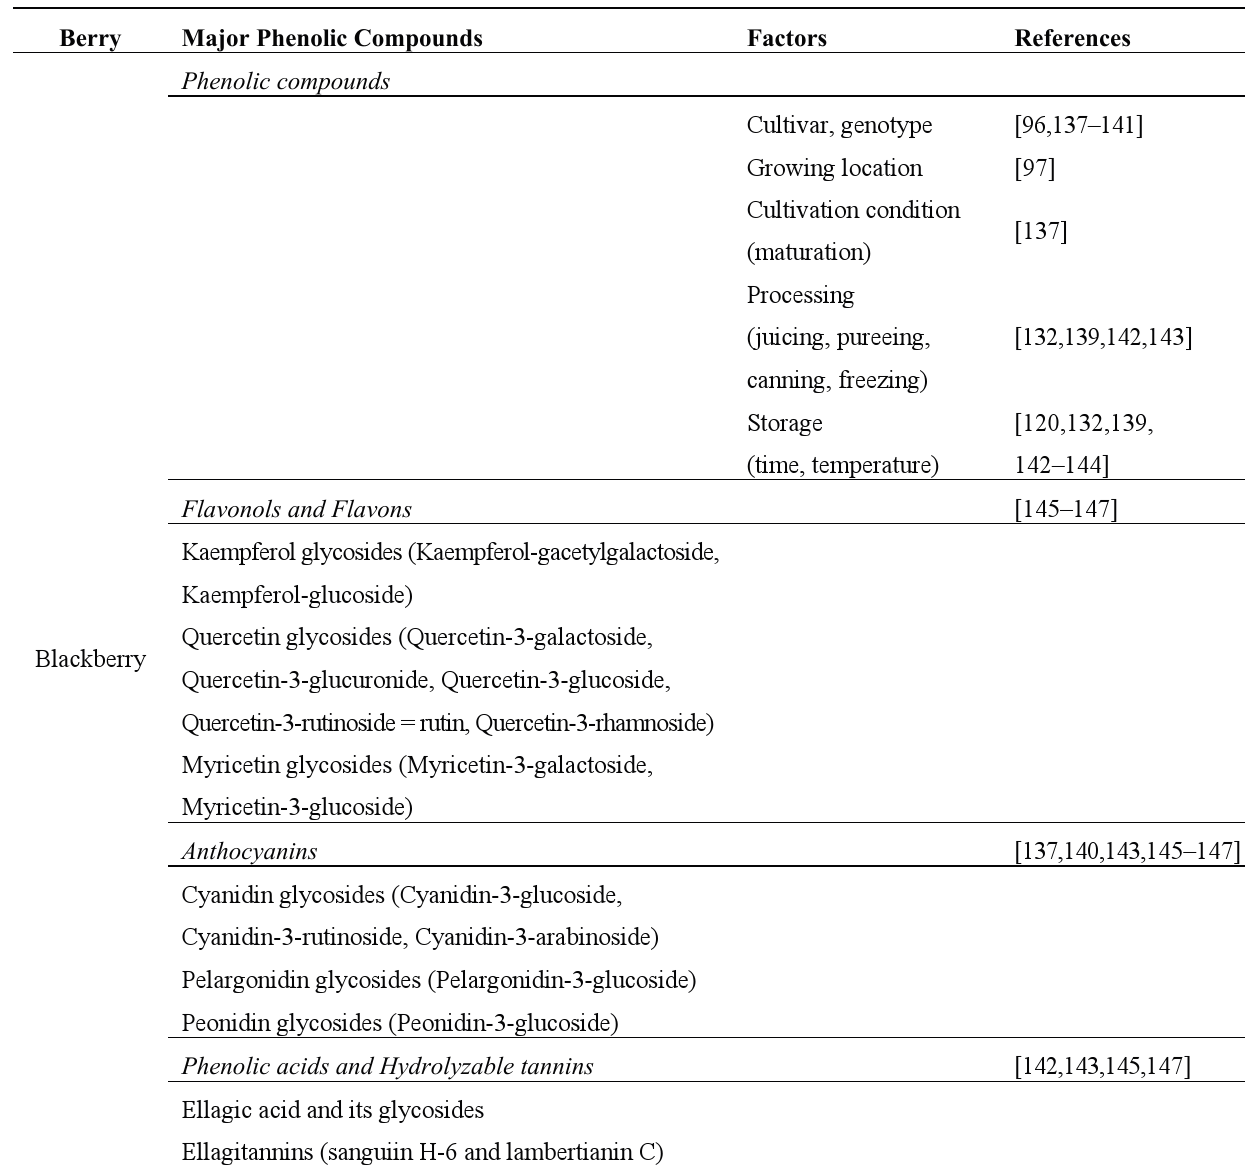
Table 3. Phenolic composition and factors influencing the composition of